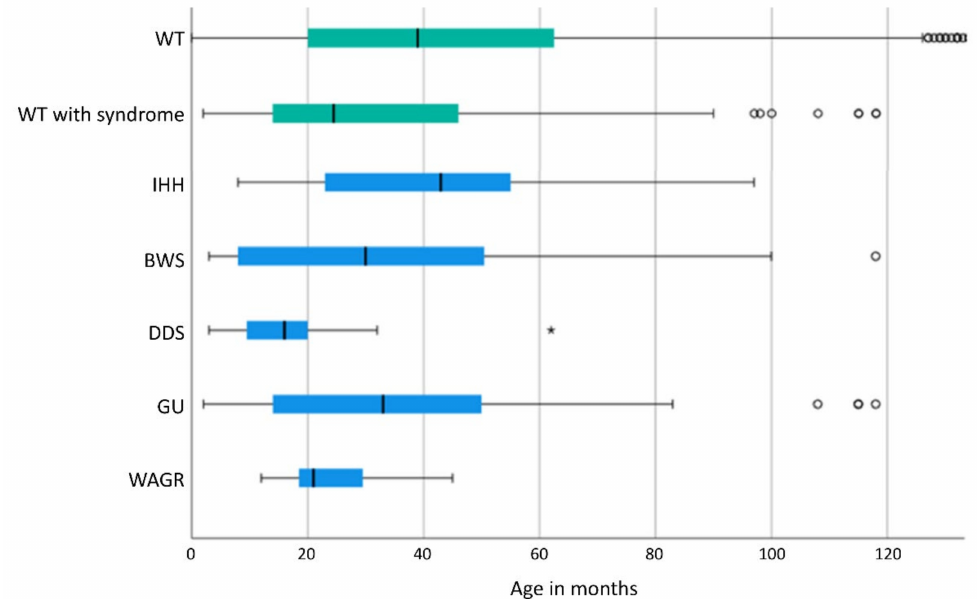
Figure 1. Age of WT/nephroblastomatosis at diagnosis of syndrome-associated WTs displayed as a boxplot (The line in the bar shows the median, the left end of the bar the lower quartile and the right end of the bar the upper quartile, the horizontal line ranges from the minimum to the maximum of data with dots and stars as outliers). DDS and WAGR show a significant lower age at diagnosis compared to all other syndromes ( p < =0.001). In 3 patients with CPS WT was diagnosed beyond 10 years of age (IHH (173 months), GU (146 months, 325 months)) and in 143 WT without a syndrome beyond 120 months, the last one at 628 months (data not shown). WT: Wilms tumor; GU: Genitourinary malformations; BWS: Beckwith-Wiedemann spectrum; IHH: isolated hemihypertrophy; DDS: Denys-Drash syndrome; WAGR: Wilms tumor, aniridia, genitourinary abnormalities, range of developmental